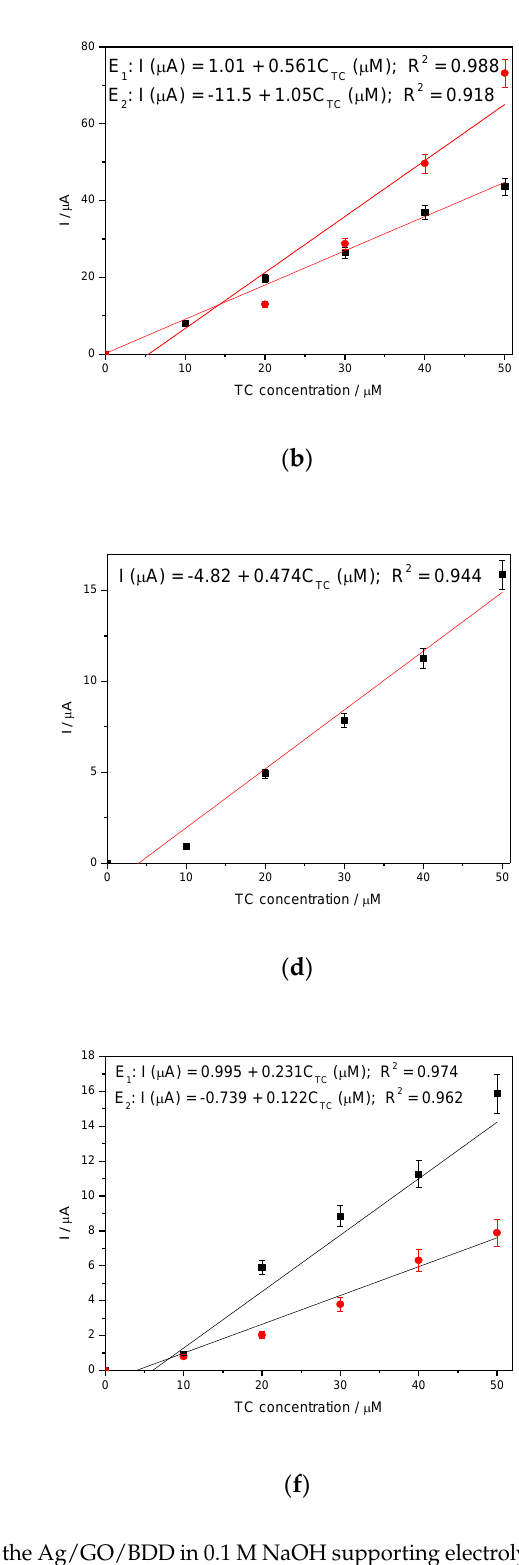
Figure 8. ( a , c , e ) Differential-pulsed voltammetry (DPV) recorded at the Ag/GO/BDD in 0.1 M NaOH supporting electrolyte and in the presence of various TC concentrations: 10–50 µ M TC; step potential (SP) of 10 mV; modulation amplitude (MA) of 100 mV; potential ranges: − 0.500 to +1.00 V/SCE ( a ); − 0.350 to +0.850 V/SCE ( c ); − 0.350 to +0.850 V/SCE with preconditioning at +1.00 V for 60s ( e ). Calibrations plots of the current vs. TC concentrations for corresponding operating conditions ( b , d , f